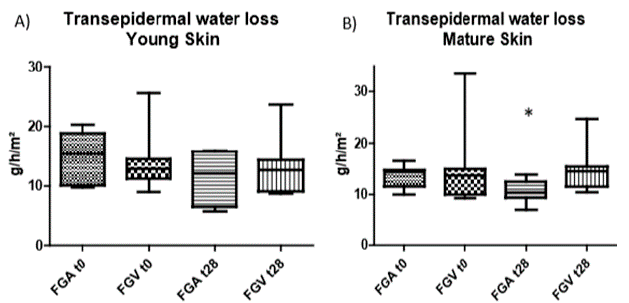
Figure 2. Transepidermal water loss before (t0), and after 28 days (t28) of application of the formu- lations FGA (gel cream containing 0.1% of Spirulina extract) and FGV (gel cream without Spirulina extract) in young skin (18–39 years) ( A ) and mature skin (40–65 years) ( B ). (* Kruskal–Wallis, p < 0.05). Published by ref.